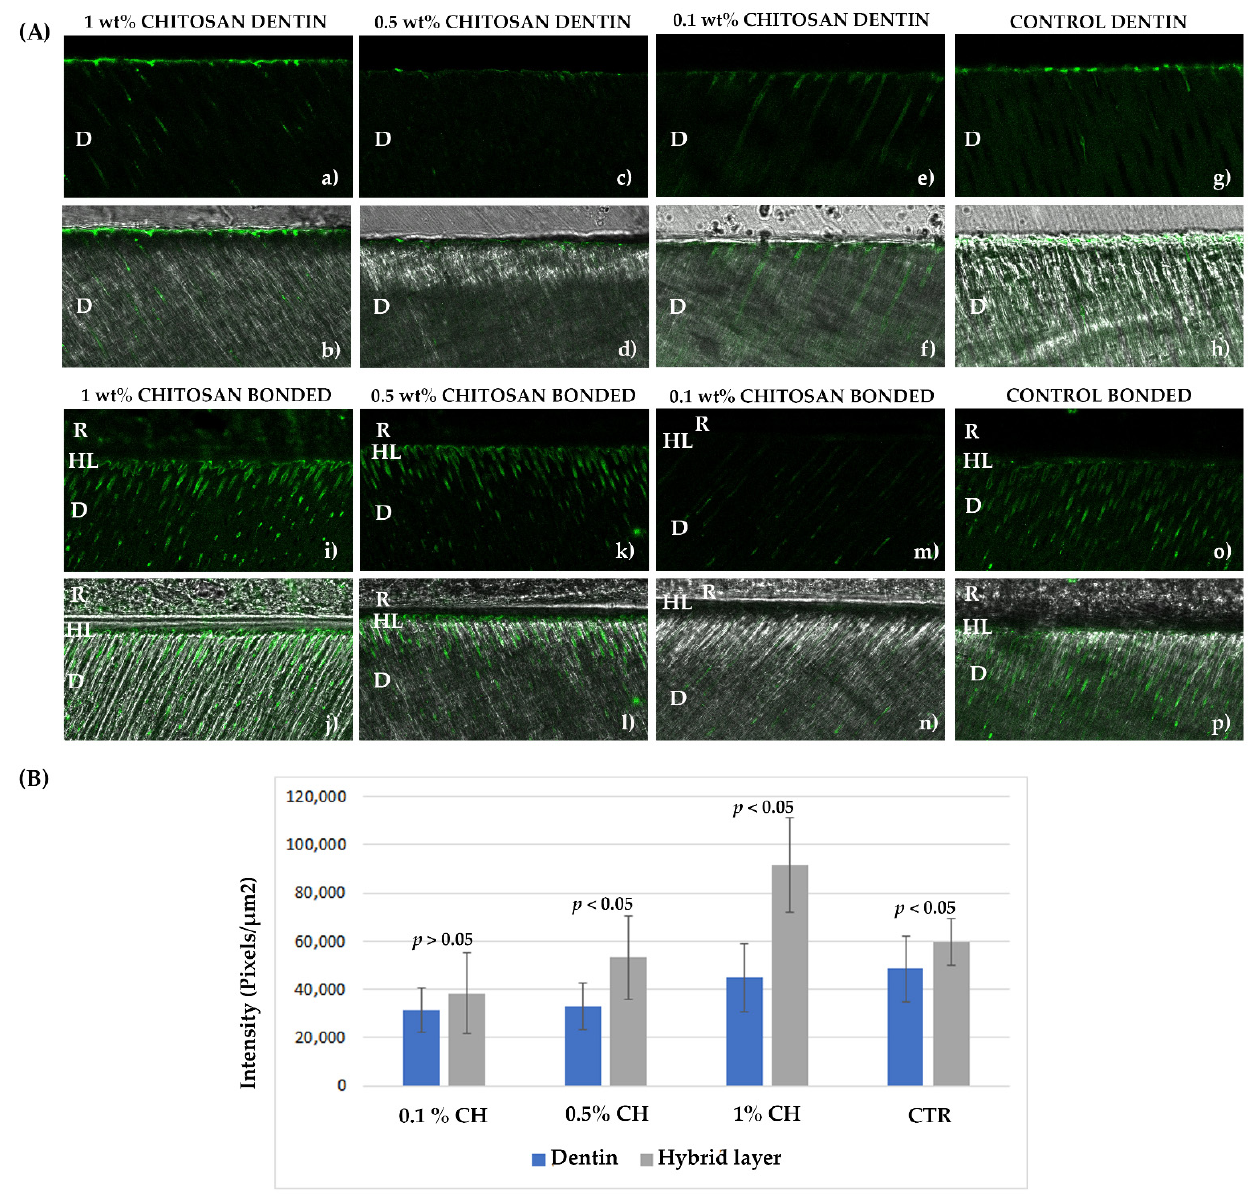
Figure 2. In situ zymography. ( A ) Images acquired in the green channel showing fluorescence within the dentin surface ( a , c , e , g ) and within the HL ( i , k , m , o ) of the tested groups. Images obtained by merging the differential interference contrast (DIC) image (showing optical density of the resin–dentin interface) and the image acquired in the green channel ( b , d , f , h , j , l , n , p ). ( B ) Quantification of the gelatinolytic activity within the dentin and the HL of the tested groups. D—dentin; HL—hybrid layer; R—resin composite.